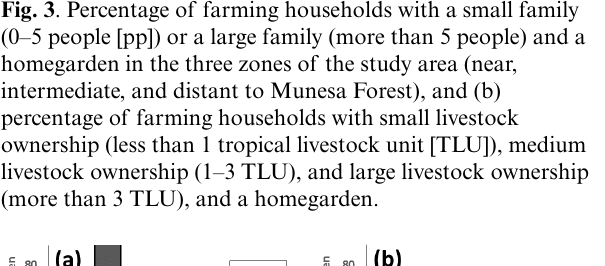
Fig. 3 . Percentage of farming households with a small family (0–5 people [pp]) or a large family (more than 5 people) and a homegarden in the three zones of the study area (near, intermediate, and distant to Munesa Forest), and (b) percentage of farming households with small livestock ownership (less than 1 tropical livestock unit [TLU]), medium livestock ownership (1–3 TLU), and large livestock ownership (more than 3 TLU), and a homegarden.